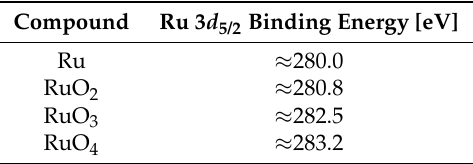
Table 3. Binding energies of Ru 3 d 5/2 state for metallic Ru and different Ru oxides [46]. Compound